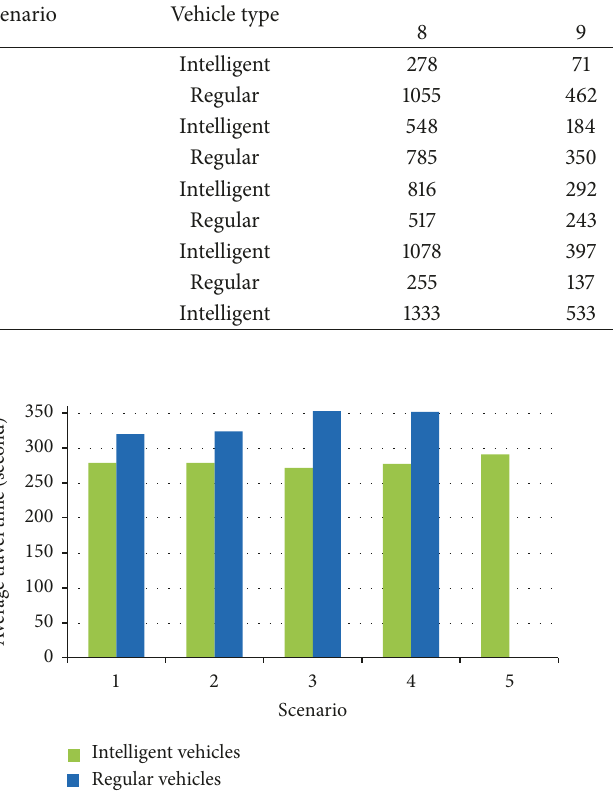
Figure 7: Average travel time with the scenarios.